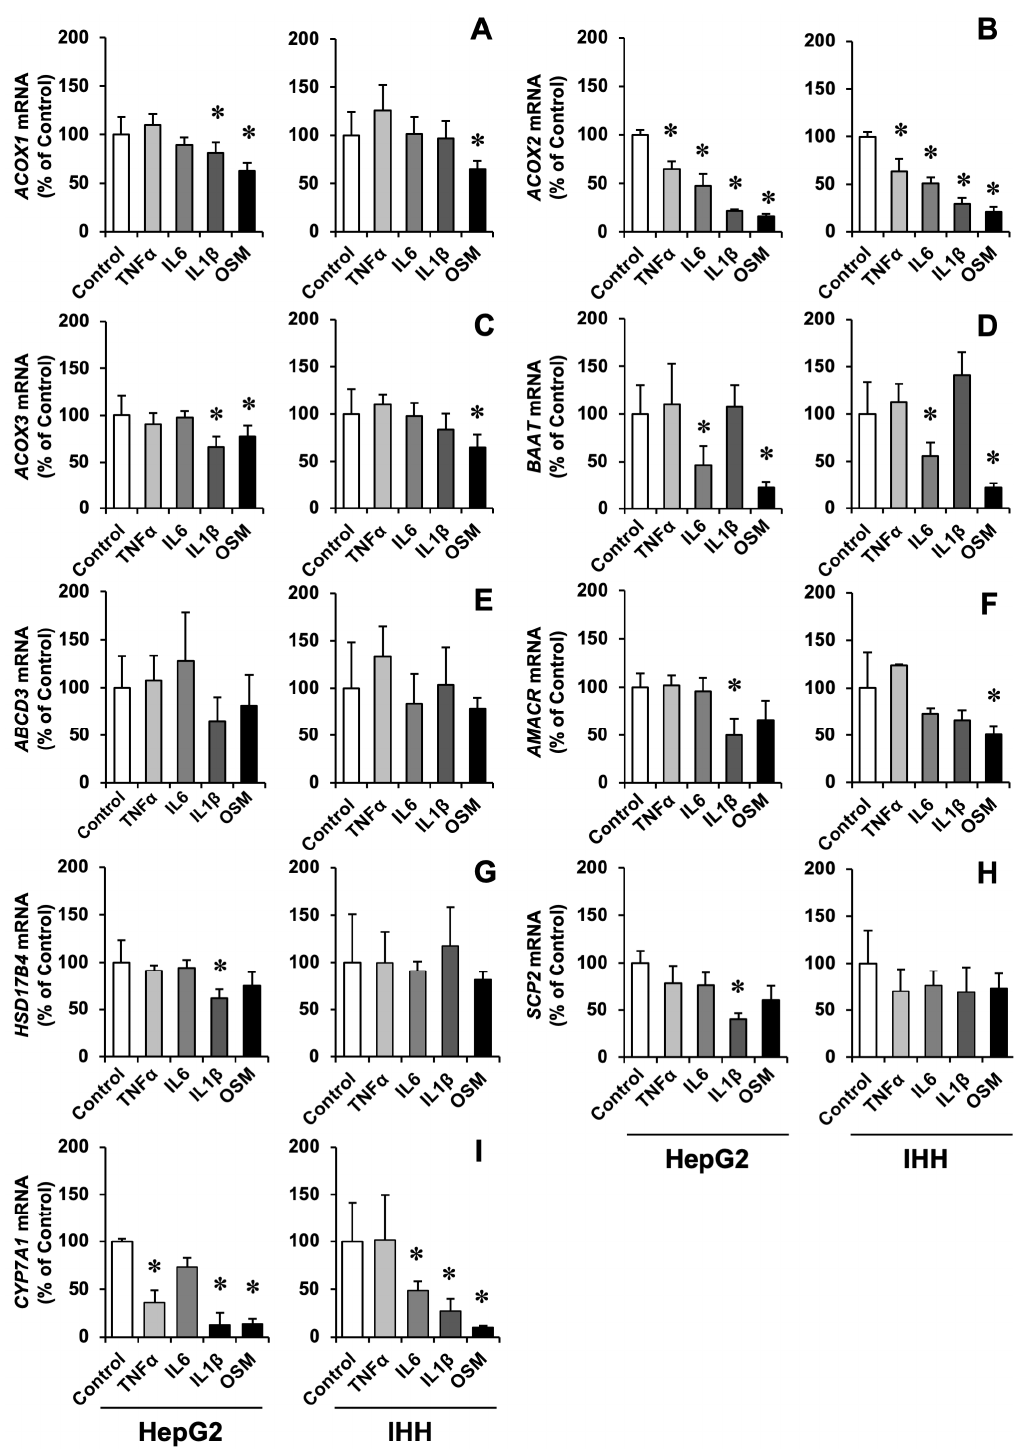
Figure 1. Relative mRNA levels, determined by RT-qPCR, of the enzymes involved in peroxisomal metabolism and transport ACOX1 ( A ), ACOX2 ( B ), ACOX3 ( C ), BAAT ( D ), ABCD3 ( E ), AMACR ( F ), HSD17B4 ( G ), and SCP2 ( H ), and in BA biosynthesis CYP7A1 ( I ) in HepG2 and IHH cells in HepG2 and IHH cells, which were incubated with 50 ng/mL tumor necrosis factor α (TNF α ), 50 ng/mL interleukin 6 (IL6), 10 ng/mL interleukin 1 β (IL1 β ) or 25 ng/mL oncostatin M (OSM) for 6 h. Results (mean ± SD) from at least three determinations carried out in three different cultures are expressed as a percentage of values found in untreated cells (Control). *, p < 0.05, as compared with Control by paired t -test.